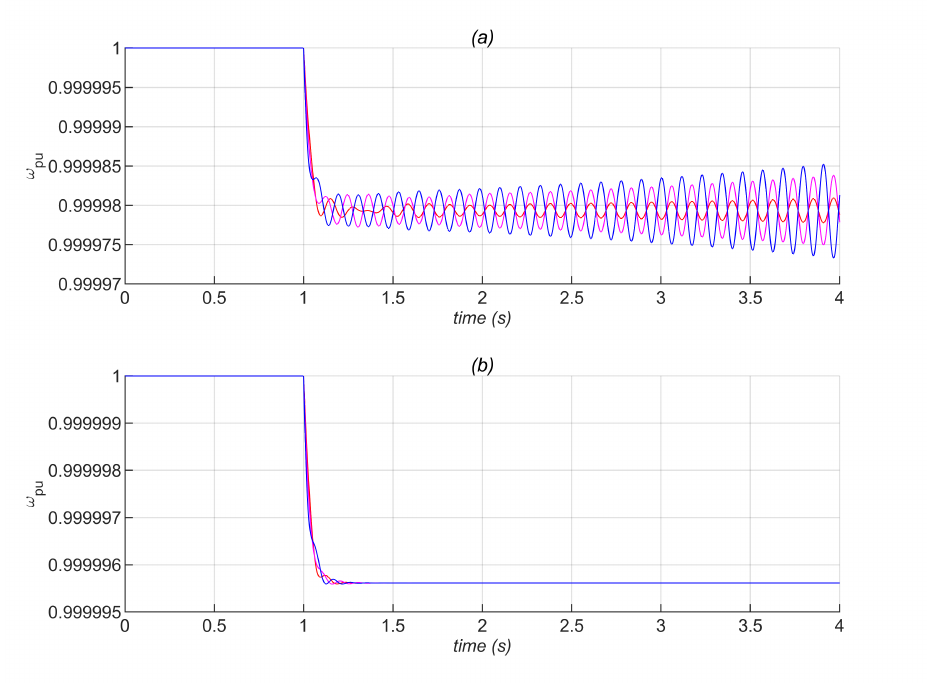
Figure 3. Frequency ( a ) Conventional using m p = 0.4%, ( b ) PFT using m p = 0.4%; at VSI Buses (1—red, 2—magenta,